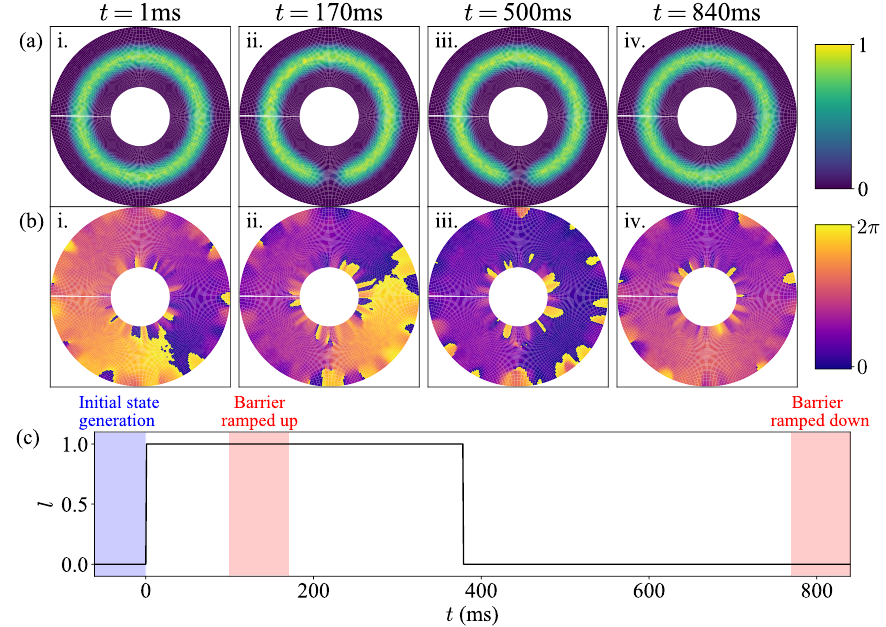
Figure 4: Single trajectory of the SPGPE for a simulation of the experimental se- quence at T = 85nK with the barrier held at its maximum strength V = 600ms. Slices of the density (peak density normalised to 1) and phase in t hold the x − y plane are shown in (a) and (b), respectively, at different times. The wind- ing number as a function of time is shown in (c), with the initial state generation period t < 0 (shaded blue) and barrier ramping periods (shaded red) shown. At time t = 1ms (i), the superfluid is in the metastable l = 1 circulation state, with